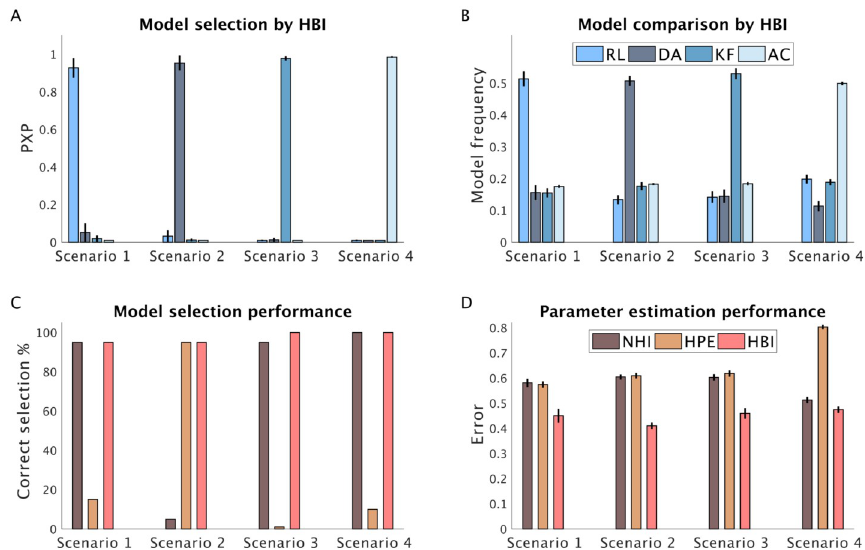
Fig 8. Performance of the HBI in a large model space. HBI was tested in a large model space including RL, dual- α (DA) RL, Kalman filter (KF) and actor-critic (AC) models in four scenarios. In each scenario, one model (the dominant model) was used to generate 30 subjects. Other models were used to generate 10 subjects. A) Model selection by HBI using protected exceedance probabilities (PXP). B) Model frequencies estimated by the HBI. Note that in each scenario, the model frequency of the dominant model is 0.5 and it is about 0.17 for the other models. C) Model selection performance (at 50%) of NHI, HPE, and HBI. D) Error in estimating individual parameters across both models and parameters. Estimation errors are computed on the normally distributed parameters, defined as the absolute difference between estimated parameters and the true parameters. In all plots, error-bars are standard errors of the mean obtained across 20